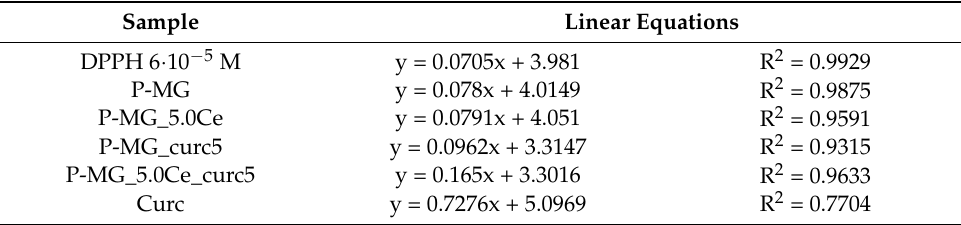
Table 6. Linear equations and related parameters for the kinetic study of antioxidant power in the DPPH test.